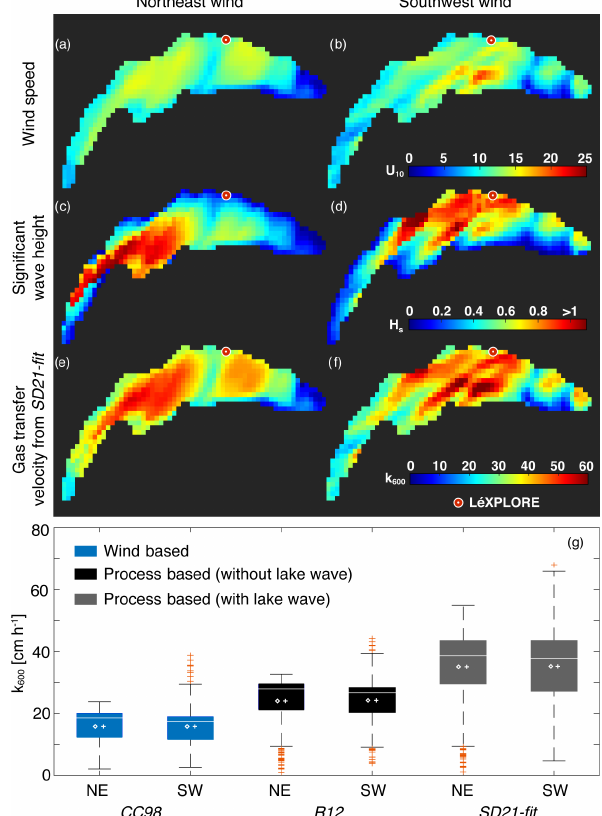
Figure 8. (a, b) Wind fields from COSMO-1 for two episodes of northeast and southwest wind directions; (c, d) wave fields on Lake Geneva considering the two prevailing winds (northeast and south- west); (e, f) gas transfer velocity from SD21-fit ; (g) boxplots of the spatial variability, at the lake scale, of k values computed from CC98 , R12 , and SD21-fit under both meteorological conditions. Di- amonds represents the spatial mean, and the cross ( + ) represents the k value computed from the averaged fetch distance (NE: 9.5km; SW: